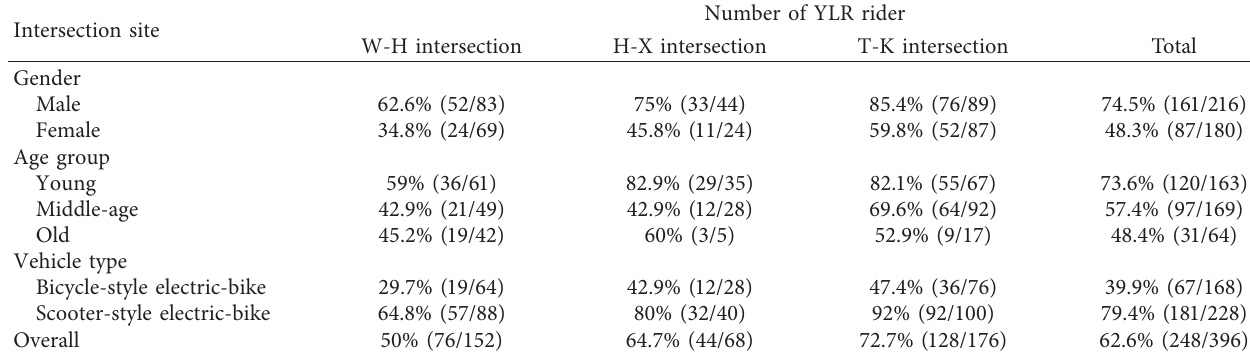
Table 3: Yellow-light running by each